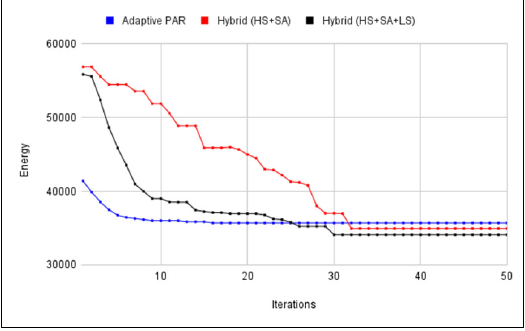
Fig. 19. Instance with 300 PM and 450 VM Fig. 20. Instance with 500 PM and 700 VM